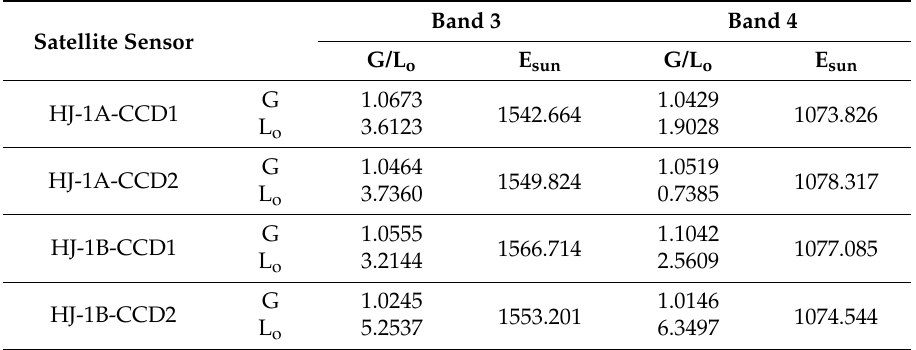
Table 5. Coefficients used for radiometric calibration and mean extraterrestrial solar irradiance (E sun